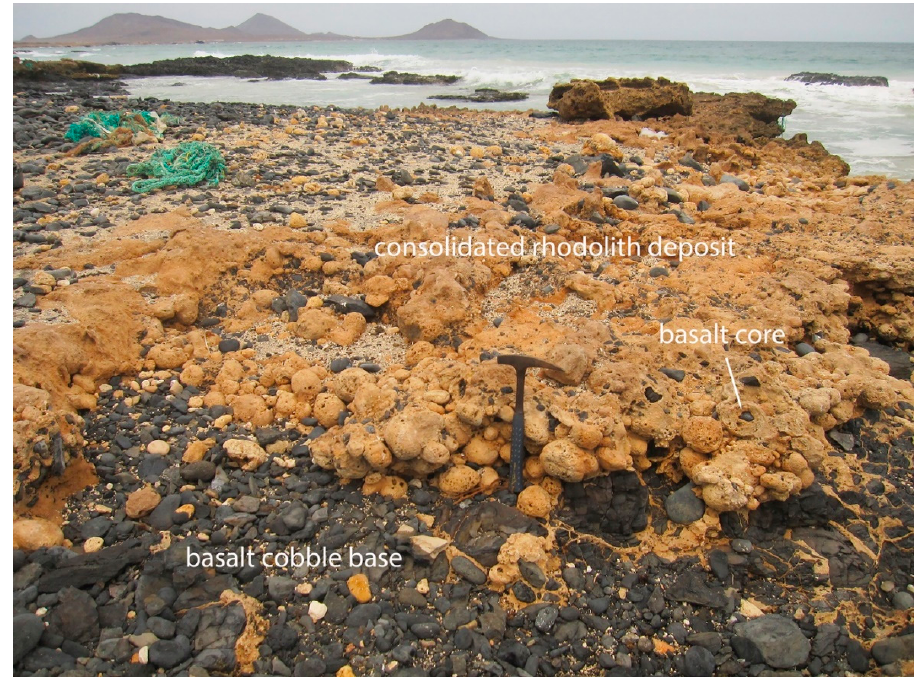
Figure 3. Close-up view of the Pleistocene rhodolith deposit at Baía da Parda showing a consolidated deposit of worn rhodoliths stacked two to three deep above a basalt cobble base (rock hammer for scale). View is to the north.